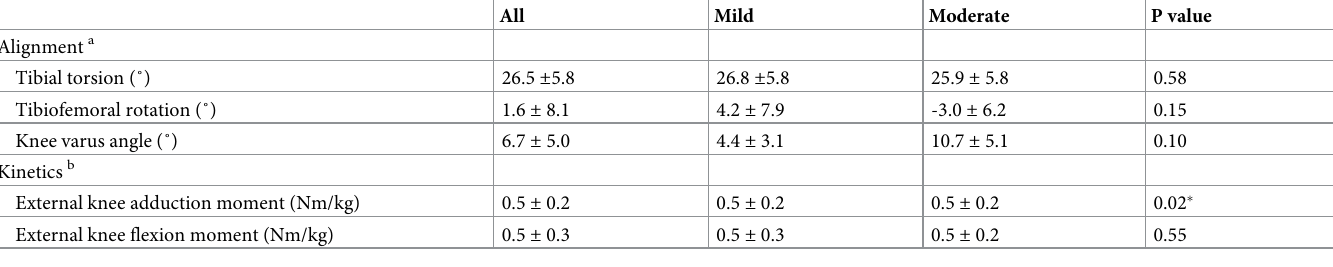
Table 3. Alignment and knee joint loads in mild and moderate knee